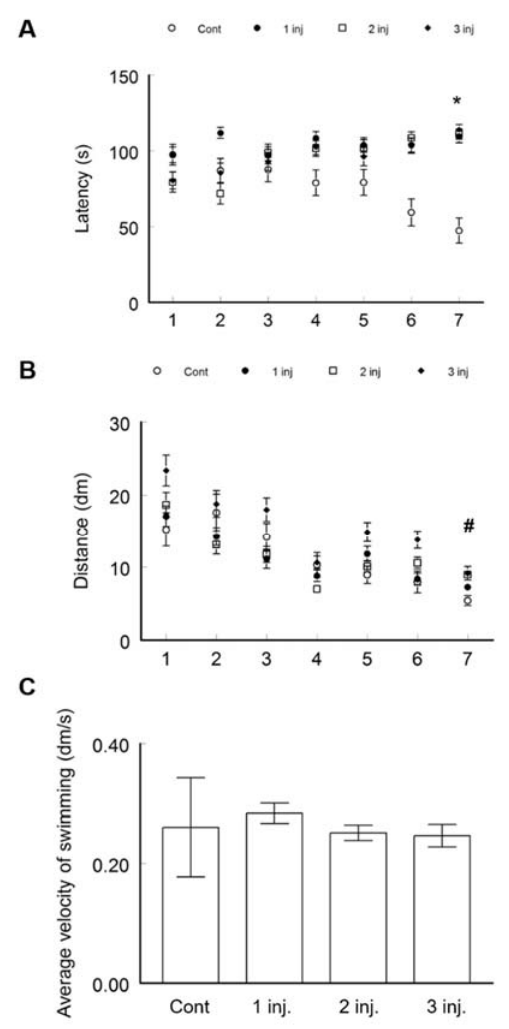
Figure 2. Spatial learning and memory assessed on BALB/C mice using a MWM. Mice were divided into four groups: a control group with no treatment, single i.v. injection in the tail vein of 0.1 mL AgNPs, two IV injections with a one week span and three i.v. injection over 3 weeks duration. ( A ) Latency to reach the hidden platform in the pool. * p < 0.05 when comparing the AgNP treated groups to the control group after 7 trials. ( B ) Distance swam to reach the platform. # p < 0.05 when comparing the AgNP treated groups with 2 and 3 injections to the control group after 7 trials. ( C ) Average swimming speed. Data are expressed as mean ± SEM ( n = 3).